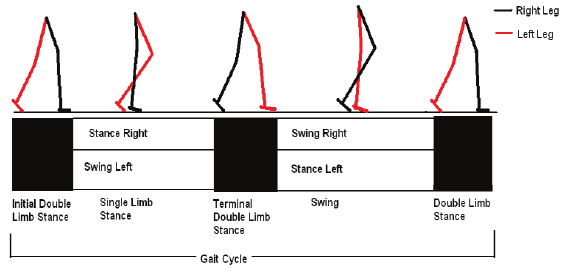
Fig. 1. Human gait period within a complete gait cycle